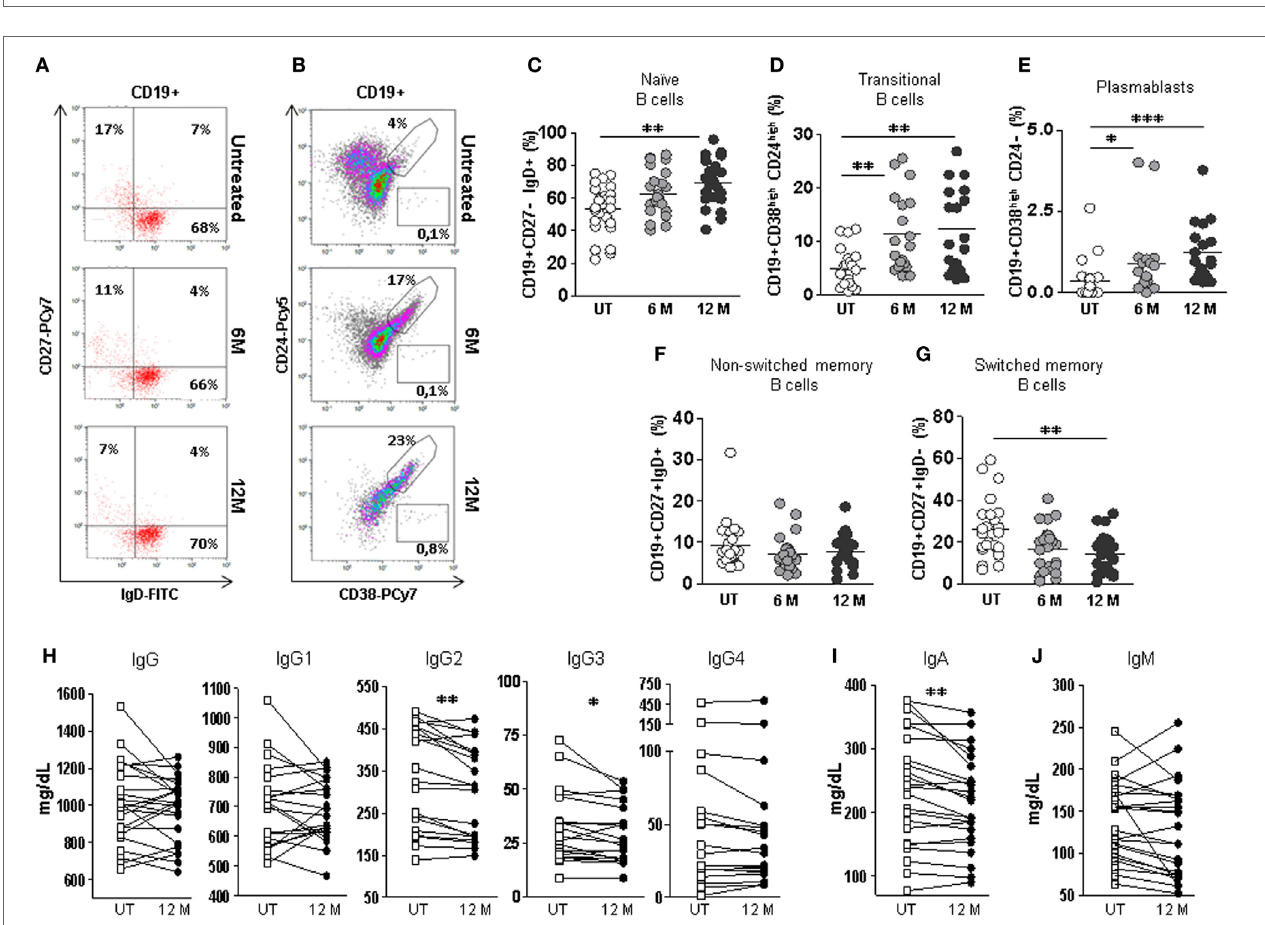
FigUre 4 | Effect of dimethyl fumarate on B cells subpopulations and serum levels of immunoglobulins in multiple sclerosis (MS) patients. (a) Dot-plots of the percentages of peripheral naïve CD19 + CD27 − IgD + (lower right quadrant), non-switched memory CD19 + CD27 + IgD + (upper right quadrant), and switched memory CD19 + CD27 + IgD − (upper left quadrant) B cells on total CD19 + gated B cells from a representative untreated (upper row), 6 months treated (6 M: middle row), and 12 months treated (12 M: lower row) MS patient. (B) Dot plots of the percentages of peripheral transitional CD19 + CD38 high CD24 high B cells on total CD19 + gated B cells from a representative untreated (upper row), 6 months treated (6 M: middle row), and 12 months treated (12 M: lower row) MS patient. (c–g) Percentages of peripheral naïve CD19 + CD27 − IgD + , transitional CD19 + CD38 high CD24 high , plasmablasts CD19 + CD38 high CD24 − , non-switched memory CD19 + CD27 + IgD + , and switched memory CD19 + CD27 + IgD − B cells from untreated (UT: white circles), 6 months treated (6 M: light gray circles), and 12 months treated (12 M: dark gray circles) MS patients. Kruskal–Wallis test p -values: * p < 0.05, ** p < 0.01, and *** p < 0.001. (h–J) Serum IgG, IgG1, IgG2, IgG3, IgG4, IgA, and IgM levels (mg/dL) from MS patients before treatment (UT: white squares) and 12 months (12 M: dark gray circles) after treatment. Successive repeated measures on the same individual are represented by connecting lines. Wilcoxon paired test: p -values: * p < 0.05, ** p <